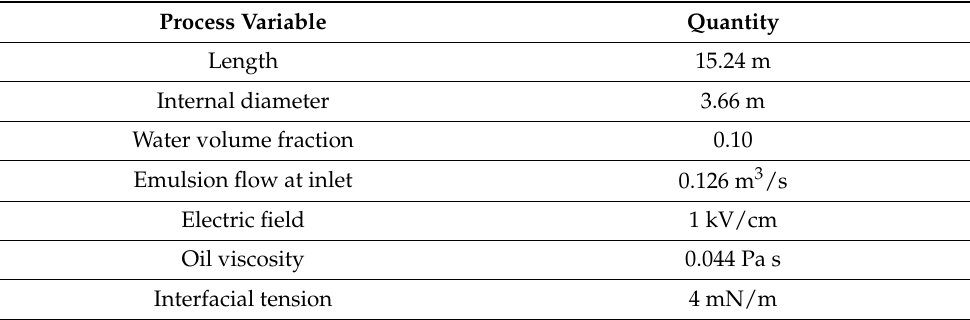
Table 4. Operating parameters of an industrial desalting